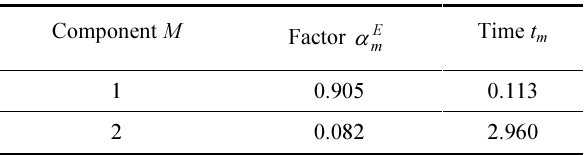
Table 1. Time-dependent properties of viscoelastic materials related to Prony series